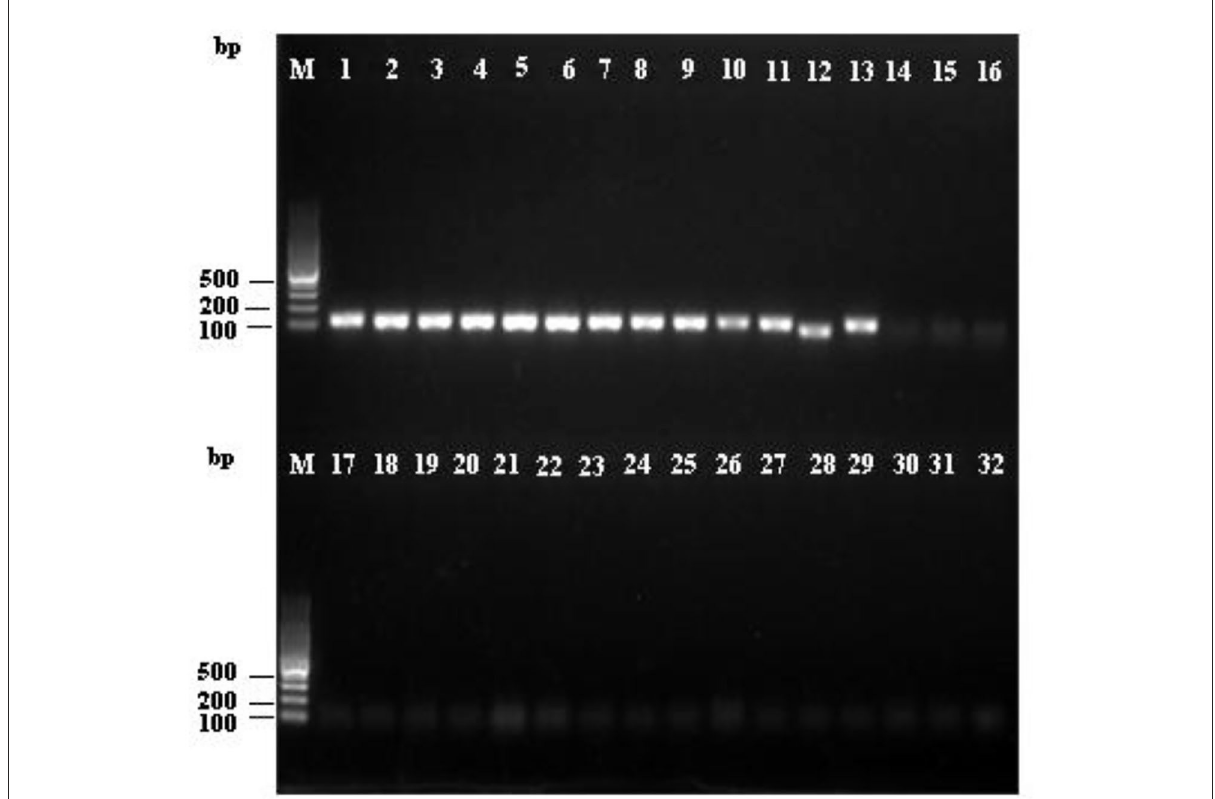
FIGURE5 Specificity of the polymerase chain reaction (PCR) assay for R. subnigricans . Amplification was detected by agarose gel electrophoresis of PCR amplification products. M: 100 bp ladder; lanes 1–9: R. subnigricans ; lanes 10–13: R. nigricans ; lane 14: R. densifolia ; lanes 15–16: R. crustosa ; lane 17: R. mairei ; lane 18: R. pulchra ; lane 19: R. chiui ; lane 20: R. risigallina ; lane 21: R. virescens ; lane 22: R. zvarae ; lane 23: R. griseocarnosa ; lane 24: R. senecis ; lane 25: R. sp.; lane 26: R. rosea ; lane 27: Lactarius kesiyae ; lane 28: R. japonica ; lane 29: R. japonica ; lane 30: Lactarius vividus ; lane 31: R. cyanoxantha ; and lane 32: ddH 2 O (blank